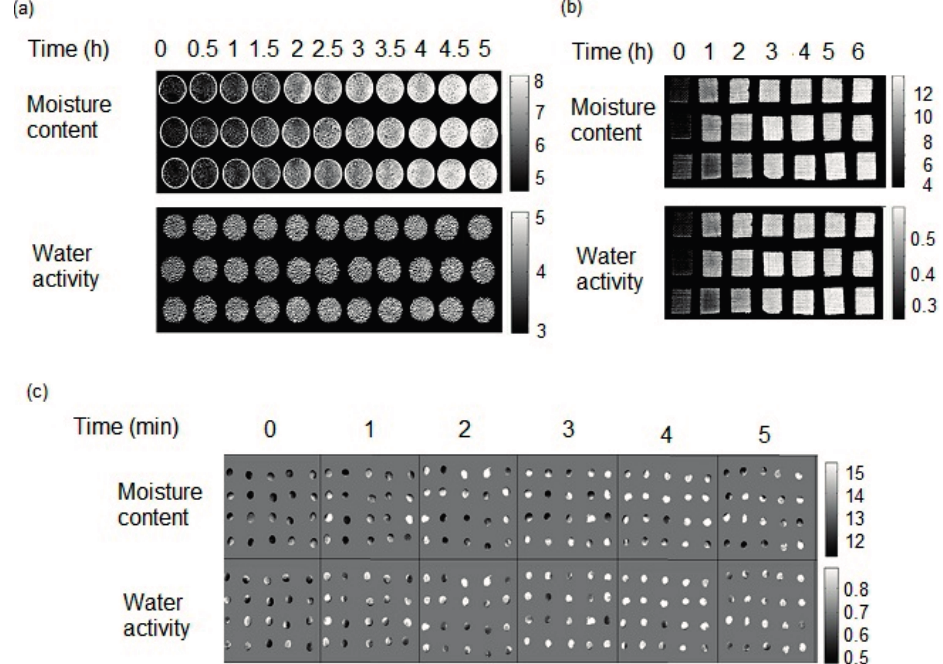
Figure 3. Predictions maps obtained by applying the best models for MC and aw to hyperspectral chemical images of ( a ) coffee ( b ) wafers and ( c ) soybean at different times. The scale bars at the side of each figure show the correspondence between pixel gray level and predicted moisture content or water